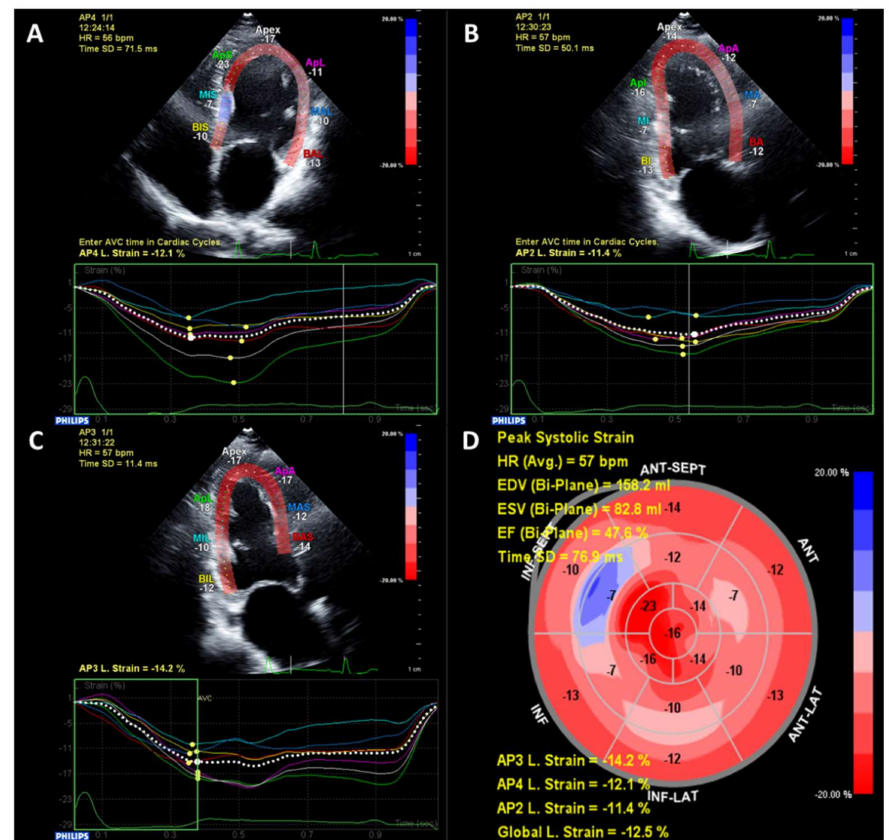
Figure 1. An example of echocardiographic speckle-tracking strain analysis. Images are taken in the apical 4-chamber ( A ), 2-chamber ( B ) and 3-chamber ( C ). A bullseye plot combining all three views is generated with reduced global longitudinal strain of − 12.5% and reduced LVEF (47.6%) ( D